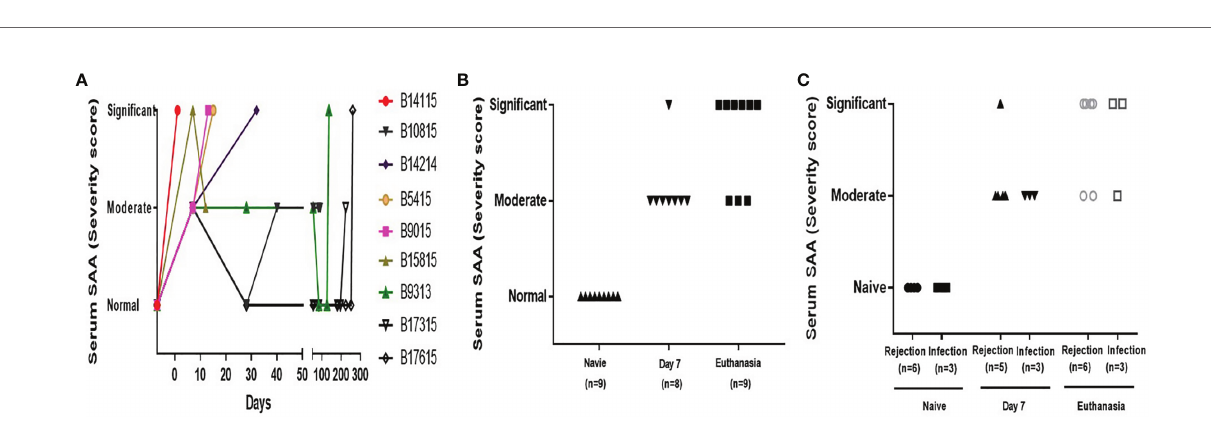
FIGURE 2 | Serum amyloid A in baboons with pig kidney grafts. (A) SAA scores in the baboons (n=9) at different time-points. (B) The difference in SAA scores in the baboons (n=9) at pre-Tx (naïve), day 7 after operation, and at euthanasia. (C) The difference in SAA scores between the rejection (n=6 or 5) and infection (n=3) groups at pre-Tx (naïve), day 7 after operation, and at euthanasia. The severity of the systemic in fl ammatory response was based on the results of the SAA assay, using a simple scoring system (1 = no in fl ammation; 2 = moderate in fl ammation; 3 = severe in fl